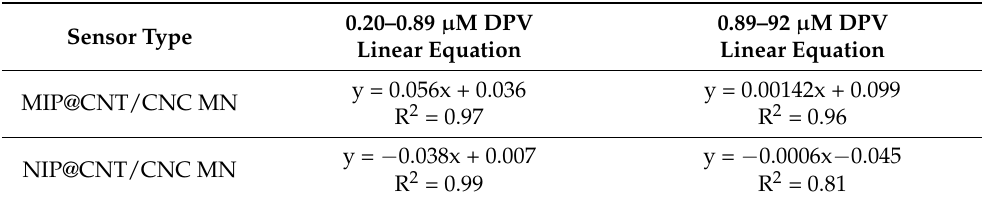
Table 3. Linear DPV calibration equations for MIP@CNT/CNC and NIP@CNT/CNC MN sensors in response to imidacloprid (IDP).